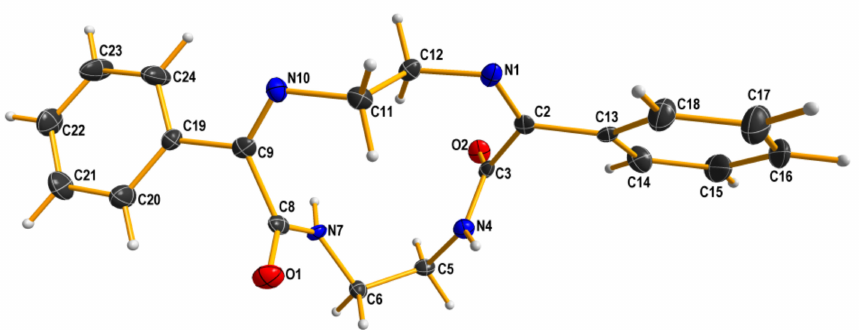
Figure 3. X-ray structure of 9 . Displacement ellipsoids are shown at the 50% probability level. Hydrogen atoms are drawn as small spheres of arbitrary radii.